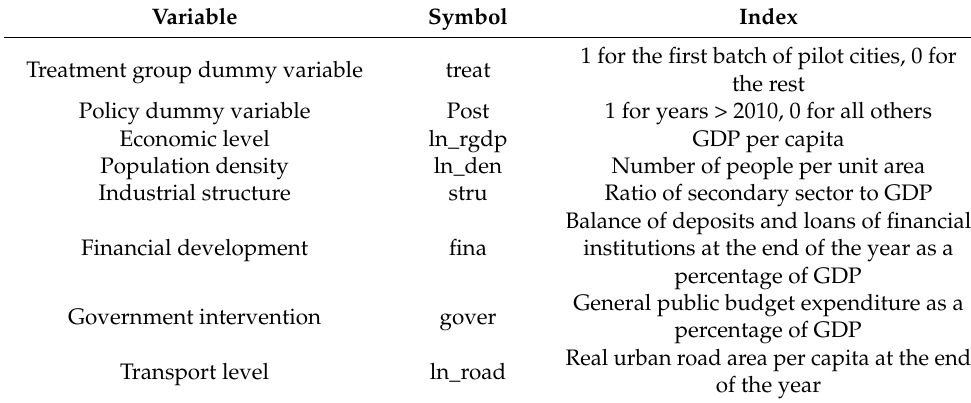
Table 1. Description of